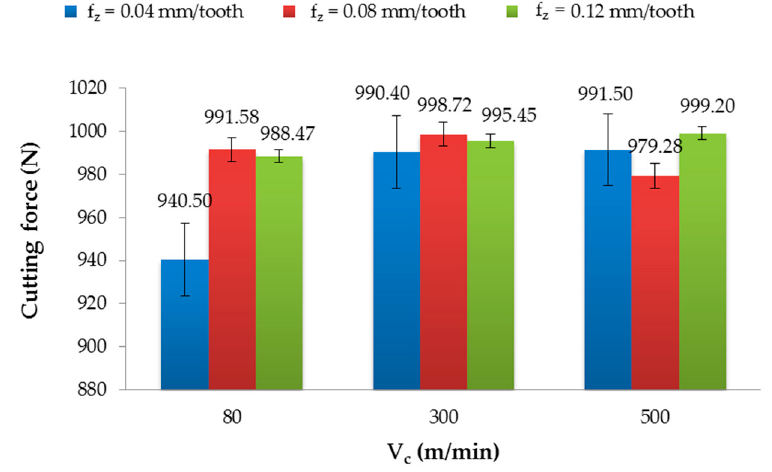
Figure 8. Cutting force in relation to the cutting speed after milling with different feeds and using a non-coated tool.